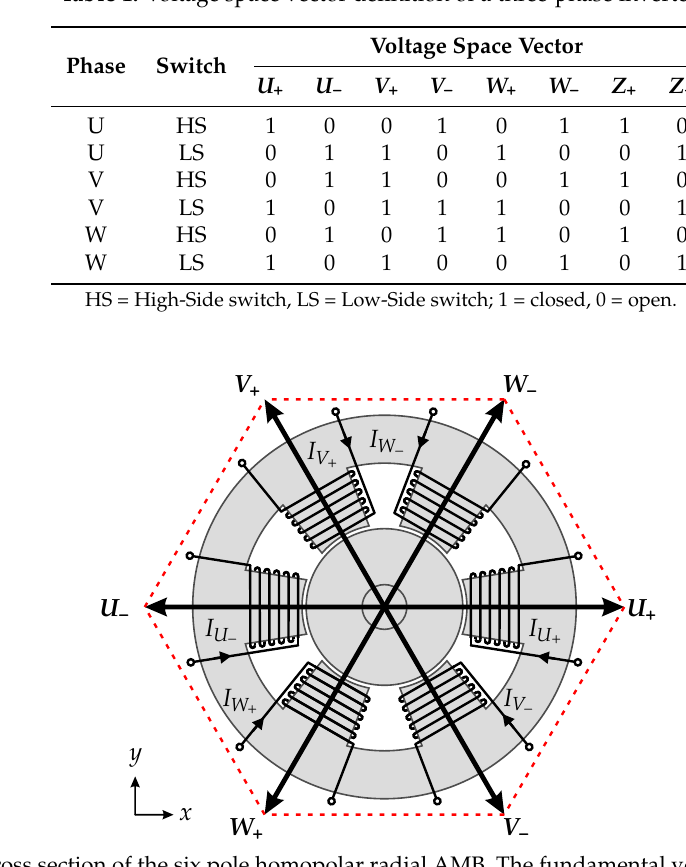
Figure 6. Cross section of the six pole homopolar radial AMB. The fundamental voltage space vectors U + , U − , V + , V − , W + , W − are aligned with the